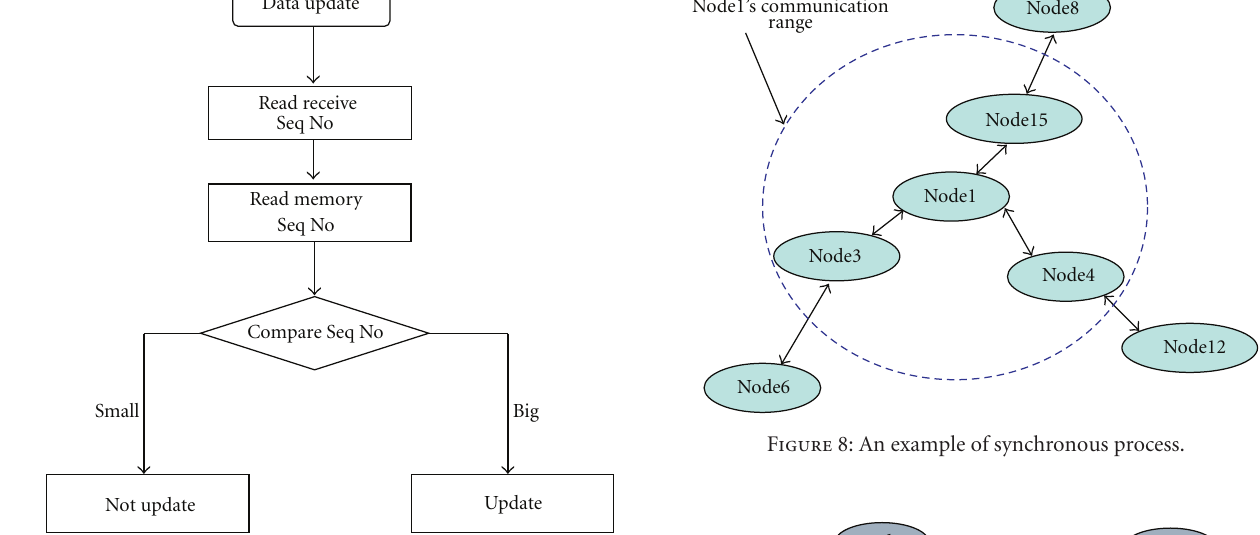
Figure 6: Data sharing update process flow chat.